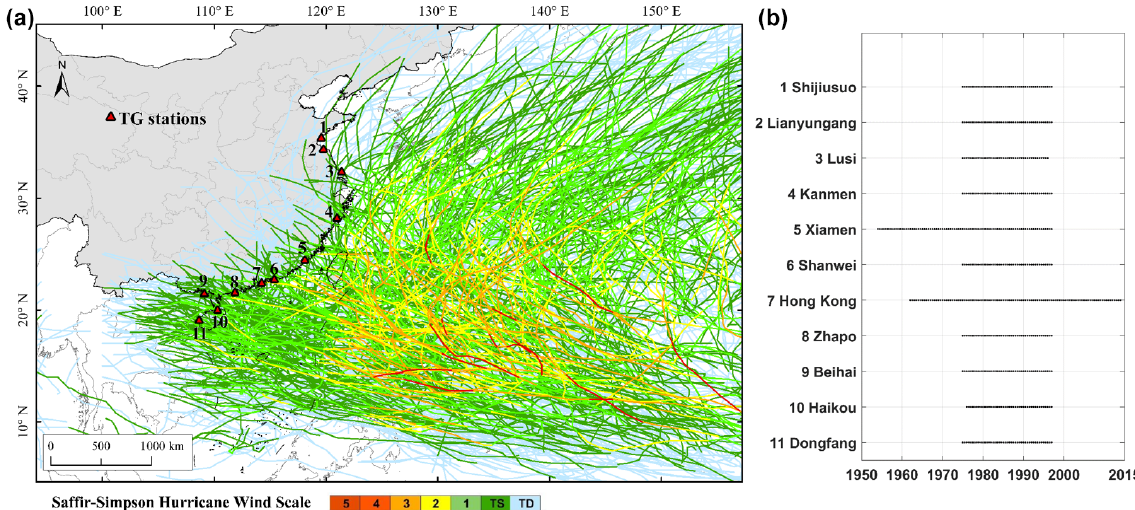
Figure 1. (a) Locations of 11 tide gauges and historical TC tracks for different intensities (only 1975–1997 shown here); (b) time periods covered by hourly sea level data at the 11 tide